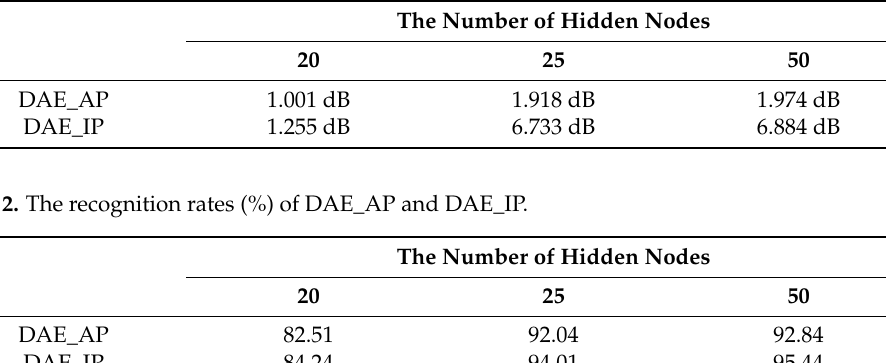
Table 1. The experimental results of DAE_AP and DAE_IP in SNR.